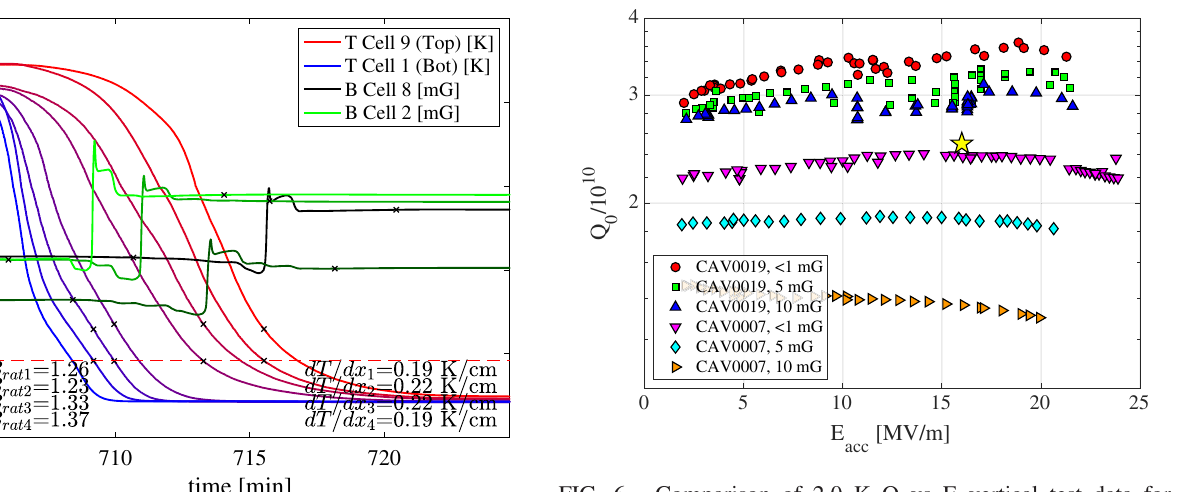
FIG. 6. Comparison of 2.0 K Q vs E vertical test data for CAV0007, which received the baseline cavity processing param- FIG. 5. Example of nine-cell cooldown of cavity in VTS eters, including 140 μ m bulk removal via electropolishing and without helium jacket. The lines with colors ranging from blue 800 °C 3 hours heat treatment, to CAV0019, which received the to red show the temperature data for cells 1 (bottom of cavity), 2, modified treatment of 200 μ m bulk removal via electropolishing 3, 4, 6, 7, 8, and 9 (top of cavity). The lines with colors ranging and 900 °C 3 hours heat treatment. Both are made with TD from green to black show the magnetic field data for cells 2, 4, 6, material and both cavities were dressed with helium vessels. and 8. The “ jumps ” in the magnetic field data line up well with Measurements were made for cooldowns in various values of the expected flux expulsion signal occurring as the respective external field. The stainless steel flanges add approximately cells pass through the critical temperature 9.2 K. B is used here 0 . 8 n Ω to the overall surface resistance. rat =B to denote the ratio B for each of the four fluxgate SC NC magnetometers. “ x ” markers indicate where temperature and magnetic field values are